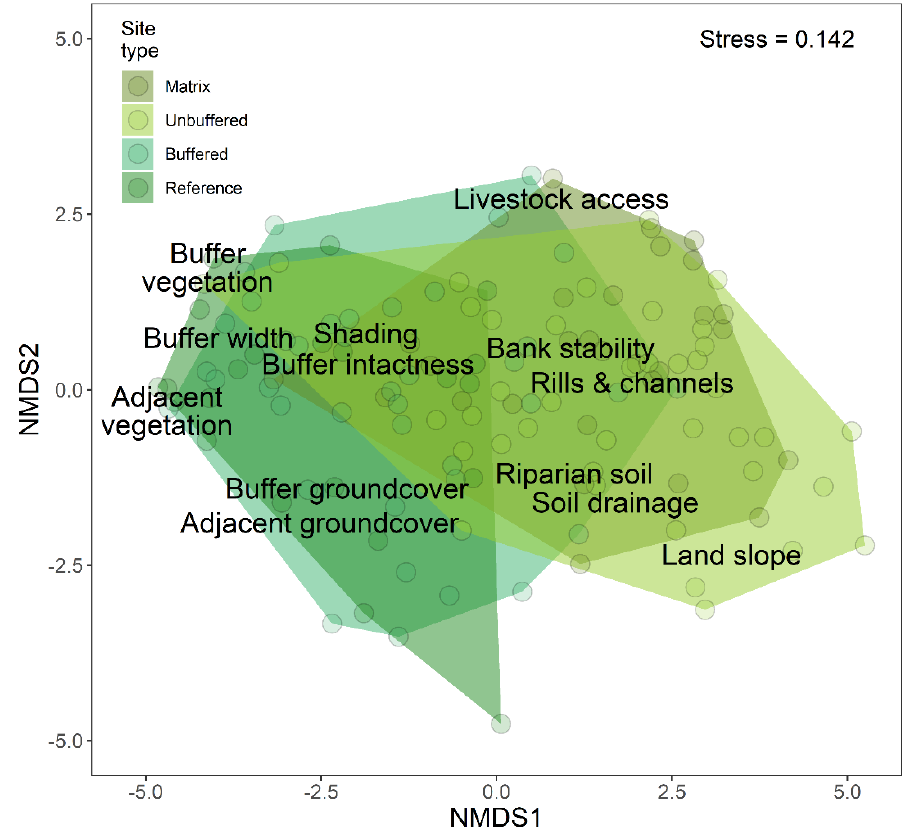
Figure 3. Unconstrained ordination (non-metric multidimensional scaling) of values for each attribute used in the Riparian Condition Index for the four site types used in the CROSSLINK project. This plot include data from sites in Norway, Sweden, Belgium, and Romania.